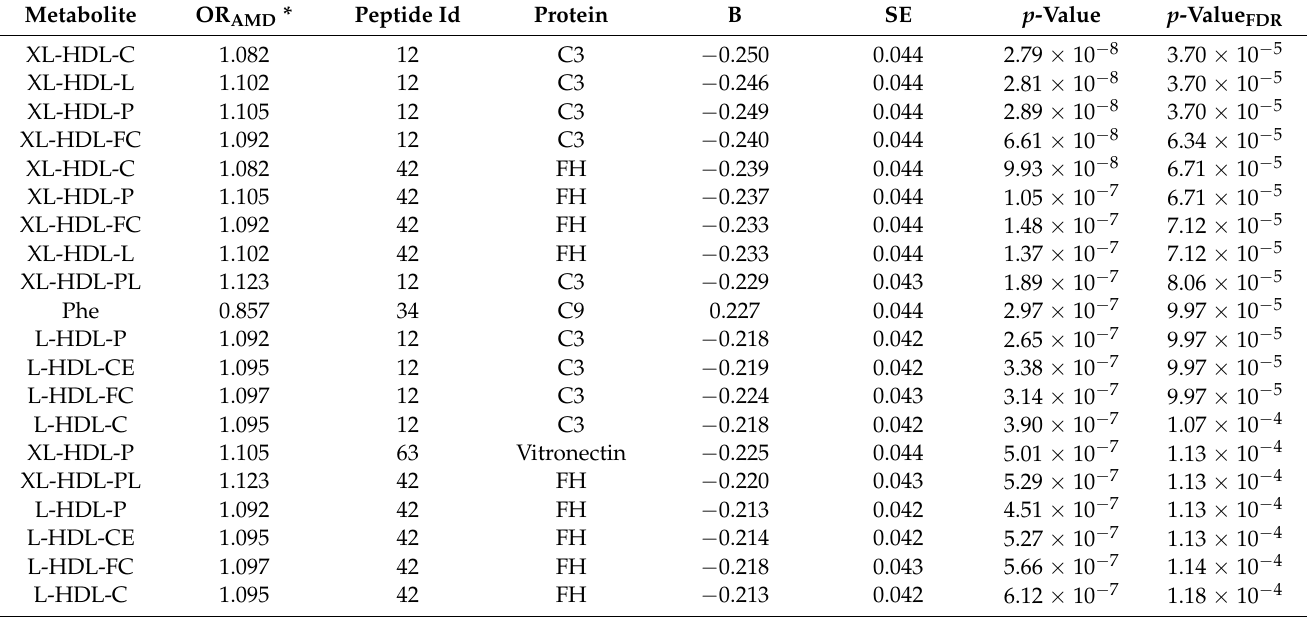
Table 4. Top 20 associations of complement peptide levels with AMD-associated metabolites. Each AMD-associated metabolite was checked for association with complement protein peptides in univariate regression